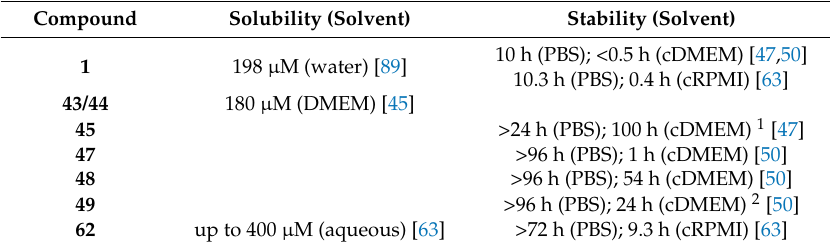
Table 18. Summarized data on solubility and stability of quercetin analogs.